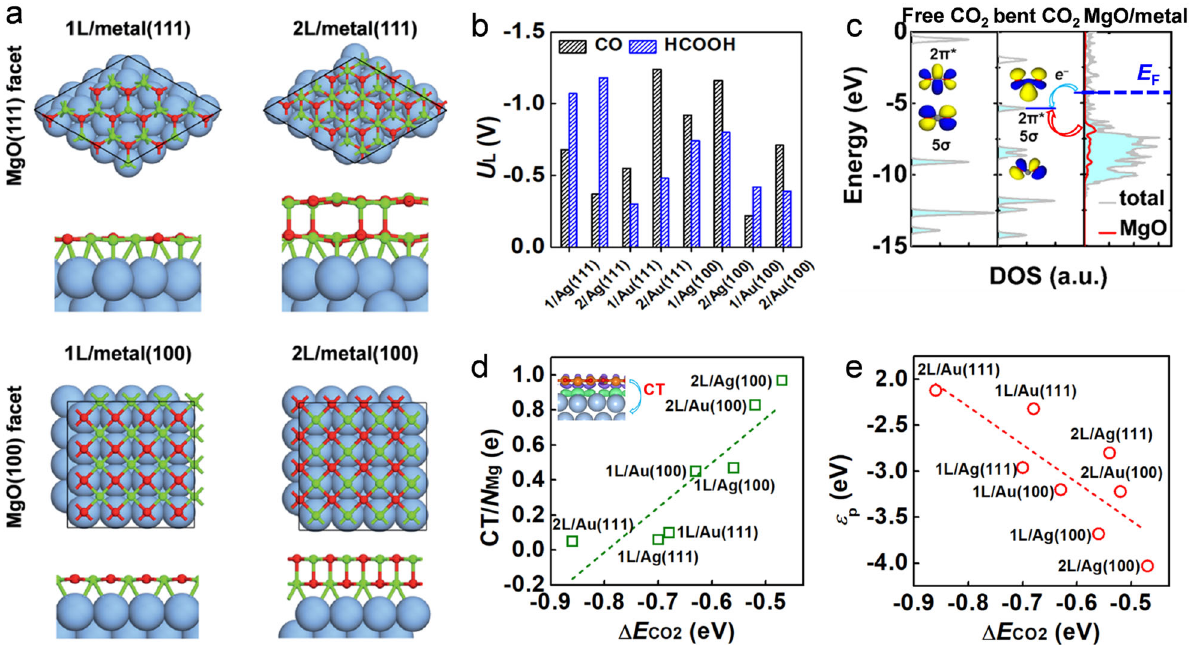
Fig. 7 CO 2 reduction on metal-supported MgO. a Top- and side-view structures of 1L and 2L MgO on the (111) and (100) surfaces of Ag and Au substrates, respectively. b Limiting potentials ( U L ) of CO 2 reduction to produce CO and HCOOH for various metal-supported MgO overlayers. c DOS of a free CO 2 molecule, a bent CO 2 molecule, and MgO/metal heterostructure, respectively. d , e Charge transfer per Mg atom from MgO sheet to the substrate (CT/ N Mg ) and p -band center ( ε p ) vs. CO 2 adsorption energy ( Δ E CO2 ) (images are adapted from ref. 209 , Copyright © The Royal Society of Chemistry